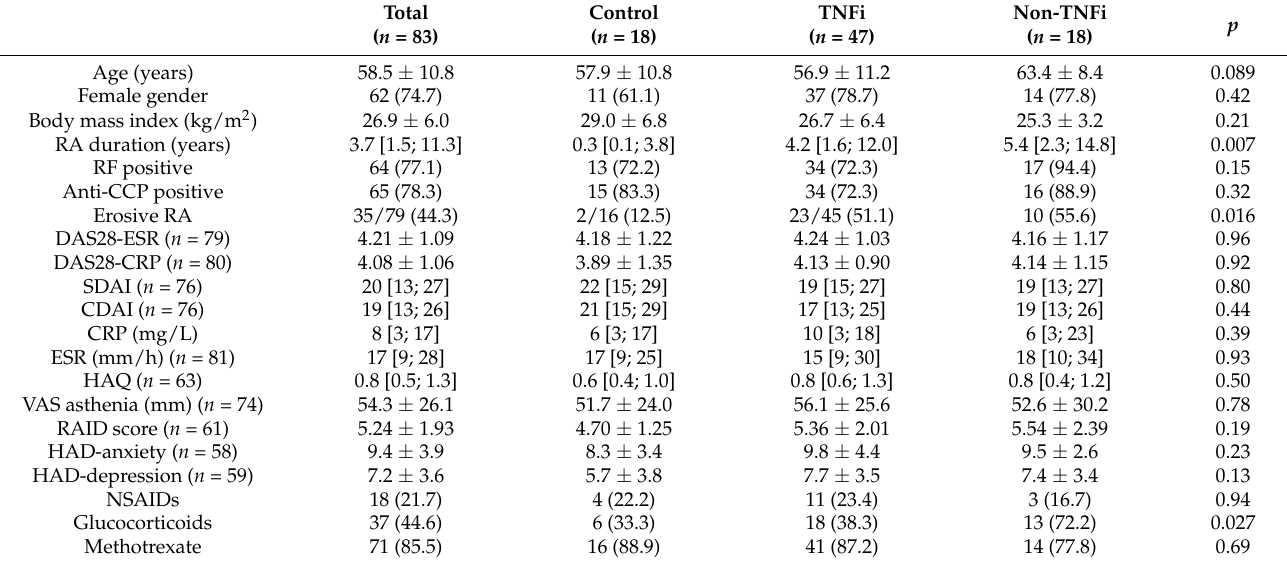
Figure 1. Flow of participants through study. RA: rheumatoid arthritis; DXA: dual energy X-ray absorptiometry Table 1. Clinical and disease characteristics of the study participants at